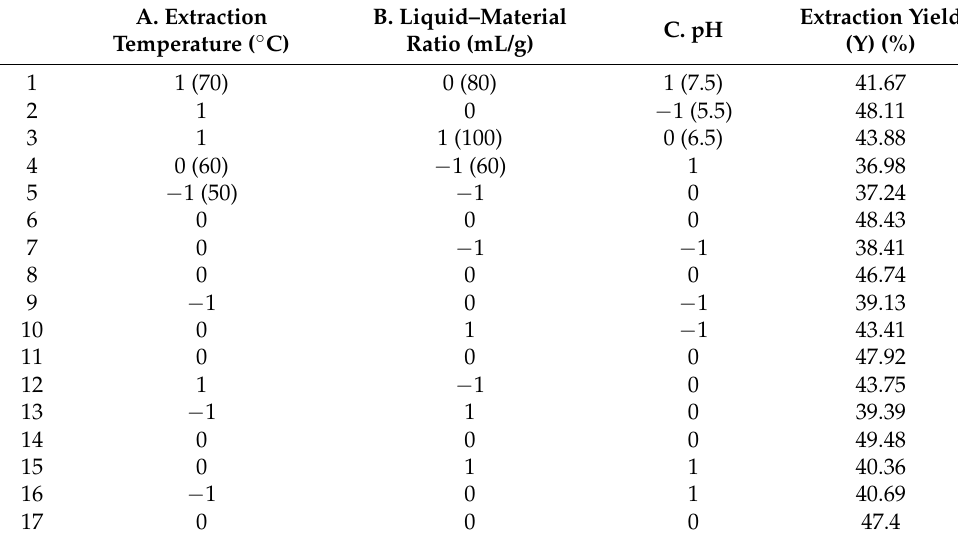
Table 1. The response values of DOPs’ extraction.